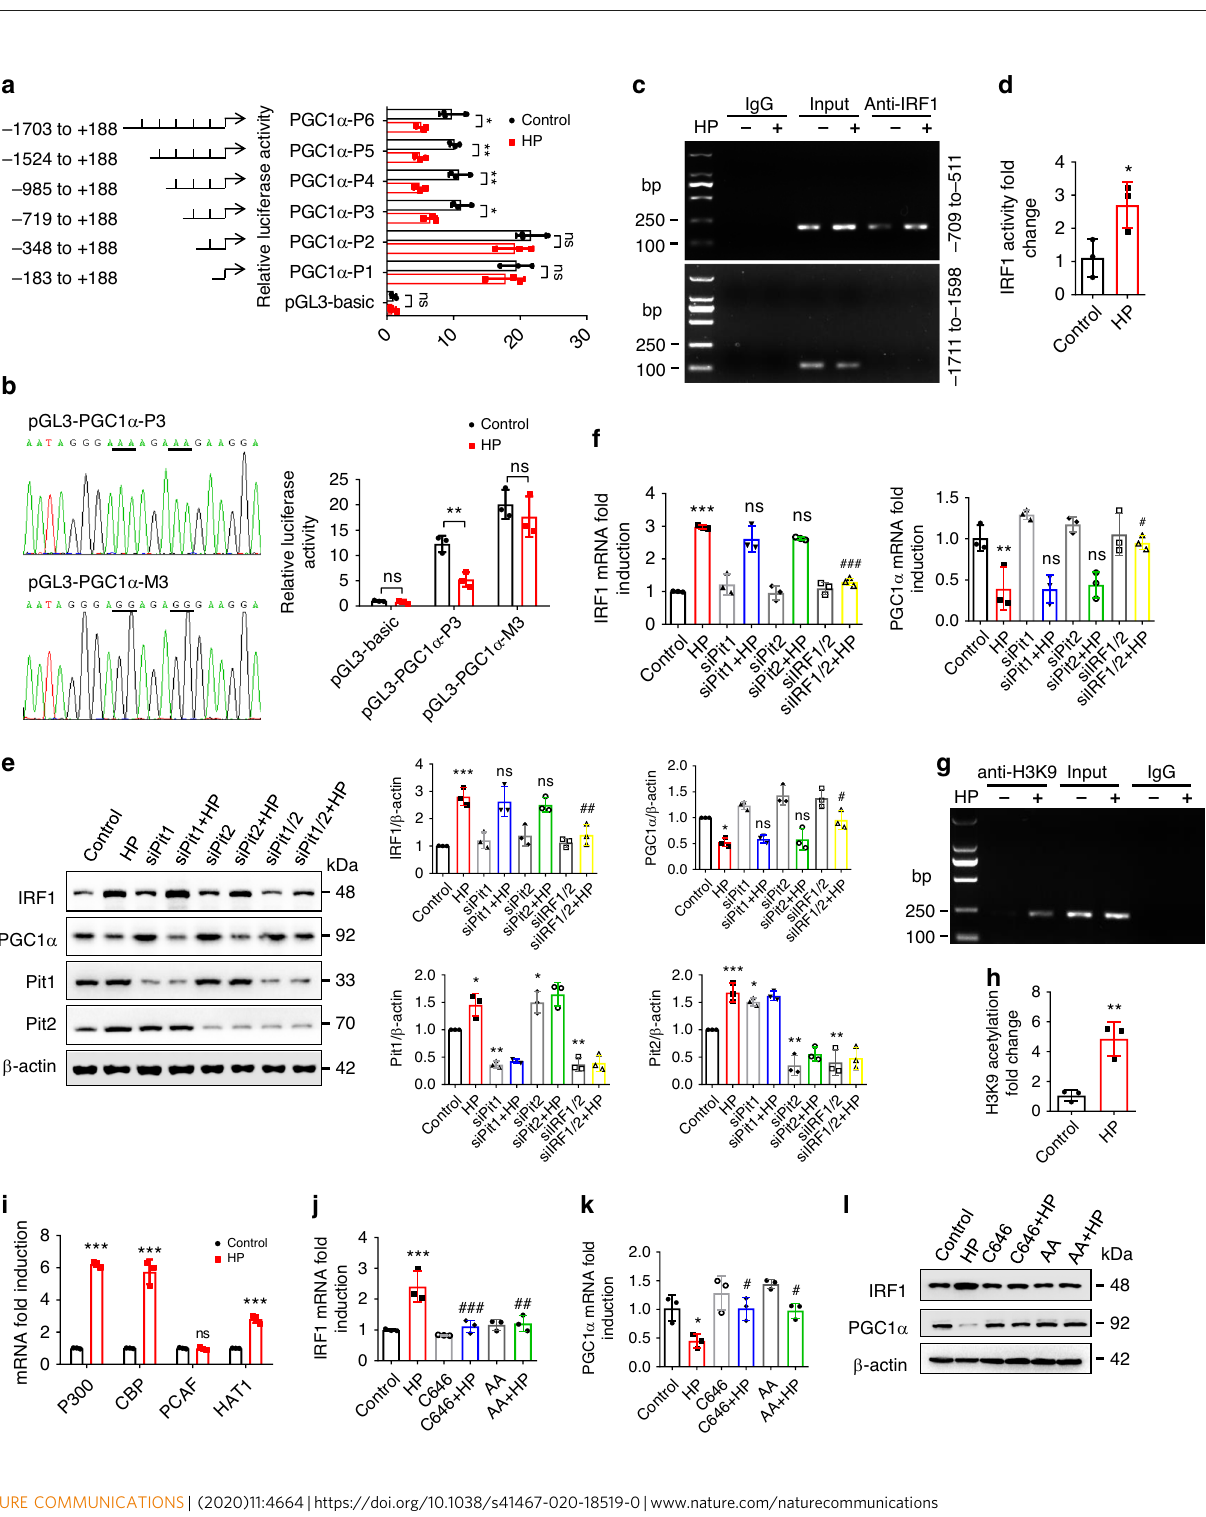
Fig. 5 HP disturbs PGC1 α expression and energy metabolism in an IRF1-dependent manner. a qPCR analysis of the expression of the predicted transcriptional factors in H9c2 cells treated with control or HP for 24 h. b , c qPCR and representative western blot analysis of IRF1 expression in H9c2 cells treated with control or various doses of HP for 24 h. d – g qPCR and representative western blot analysis of IRF1 expression in heart lysates from sham,